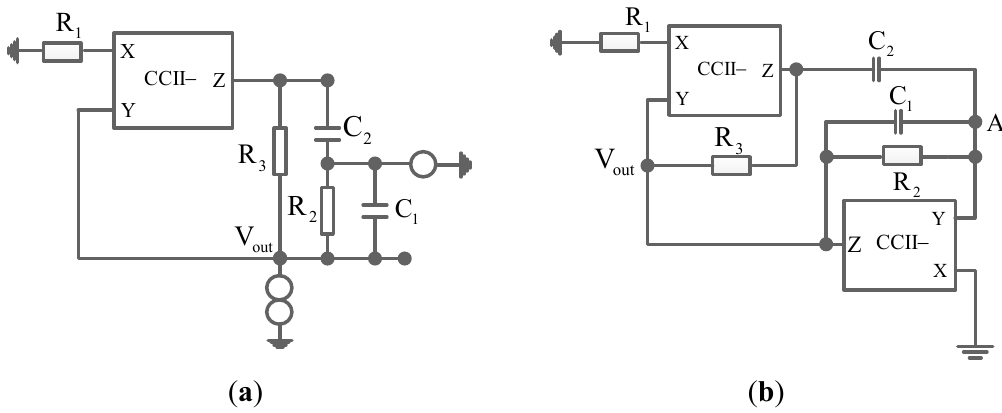
Figure 7. ( a ) Grounding input of Figure 6b; ( b ) realization of the obtained oscillator in ( a